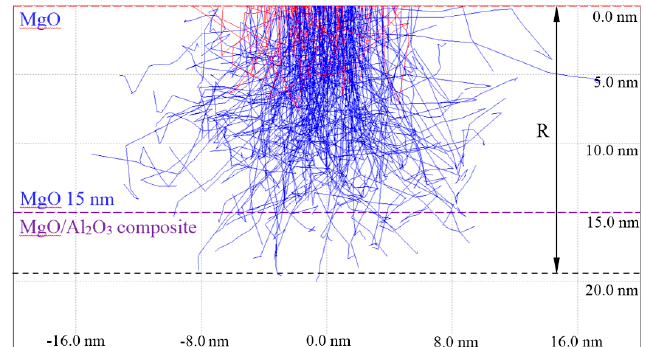
Figure 9. Monte Carlo simulation of electron trajectories in the 60 nm thick alumina-containing MgO film with the primary electron energy of 600 eV and the beam radius being 10 nm (the blue trajectories represent secondary electrons; the red trajectories represent backscattered electrons).